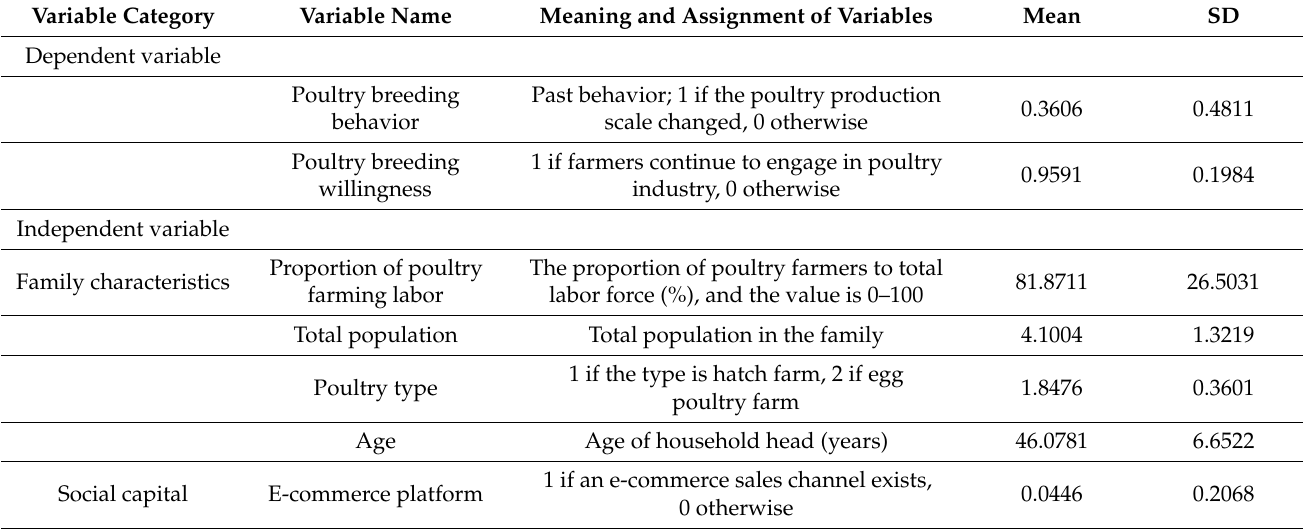
Table 1. Definition and descriptive